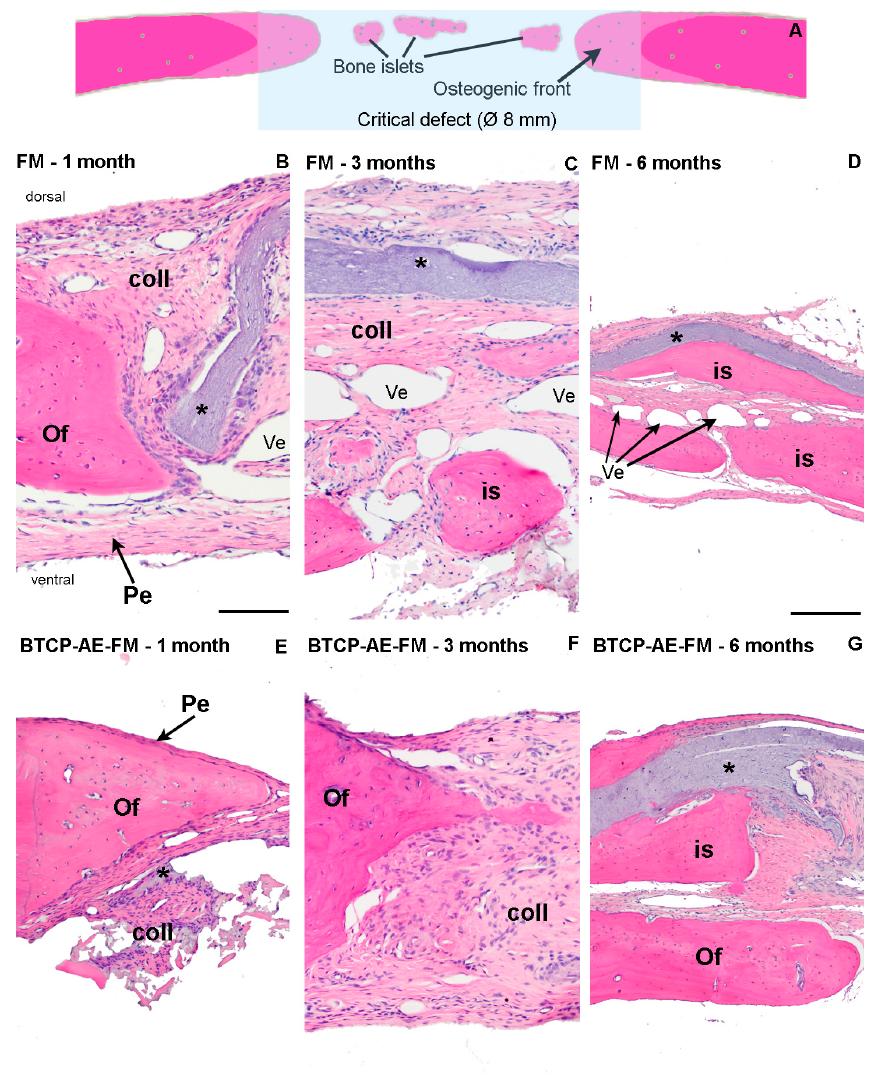
Figure 13. Histological analysis of bone remodeling in HE-stained rat calvaria plates. ( A ) The schematic diagram explains multifocal bone remodeling during calvarial defect repair. Progress of reossification was demonstrated with HE staining in the critical defect, applying polyvinyl alcohol and chitosan blended fibrous mesh (FM) ( B – D ) and inorganic composite modified polyvinyl alcohol and chitosan hybrid fibrous mesh (BTCP-AE-FM) ( E – G ) implants. Magnification: 10 × obj ( B , C , E , F ); 4 × obj ( D , G ). Pe: periosteum. Of: osteogenic front. is: bone islets. Coll: collagenous tissue. Ves: blood vessels. *: implanted fibrous mesh. Scalebar: 0.5 mm ( B , C , E , F ); 1 mm ( D , G ).